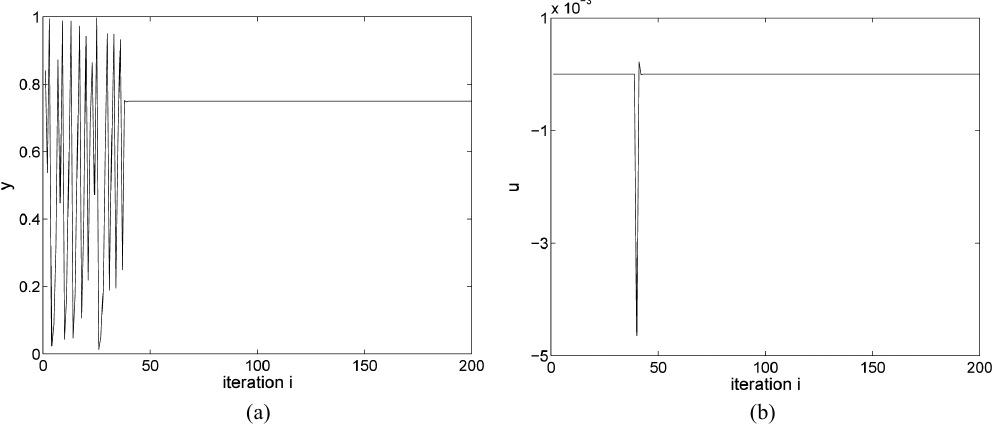
Fig. 4. T-S Fuzzy system under control. (a) Behavior of y ( i ) . (b) Control input u ( i ) .